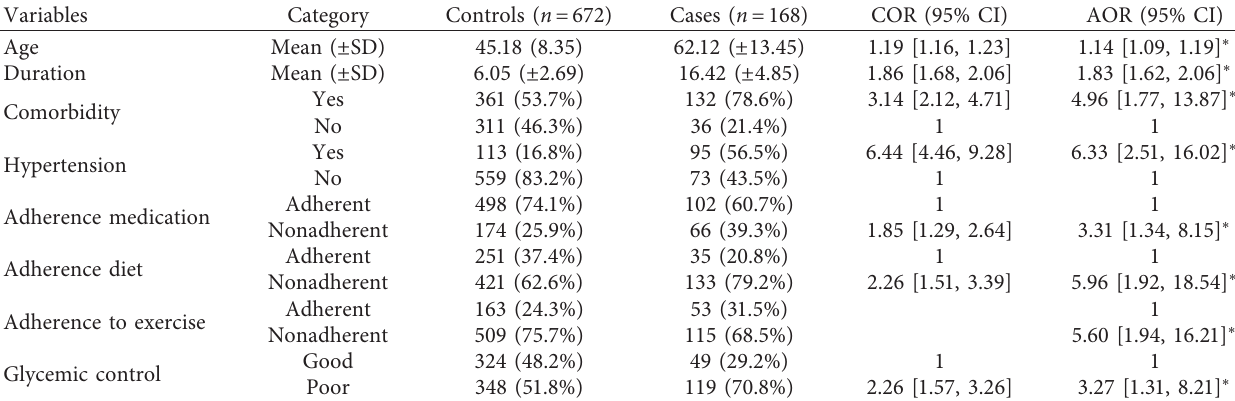
Table 4: Determinants of diabetic nephropathy among study participants on follow-up at public hospitals of Tigray region, Ethiopia, 2019.